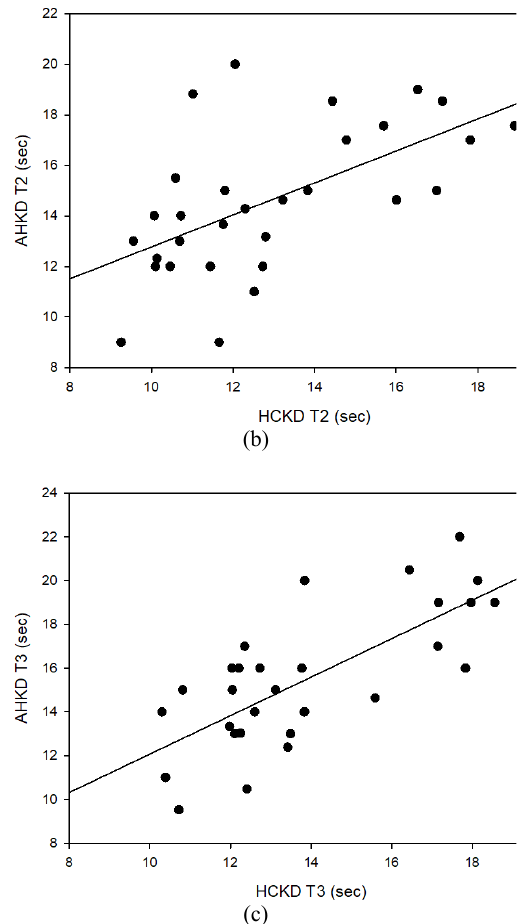
Figure 12. Correlation between HCKD and AHKD. (a) Test 1, (b) Test 2. (c) Test